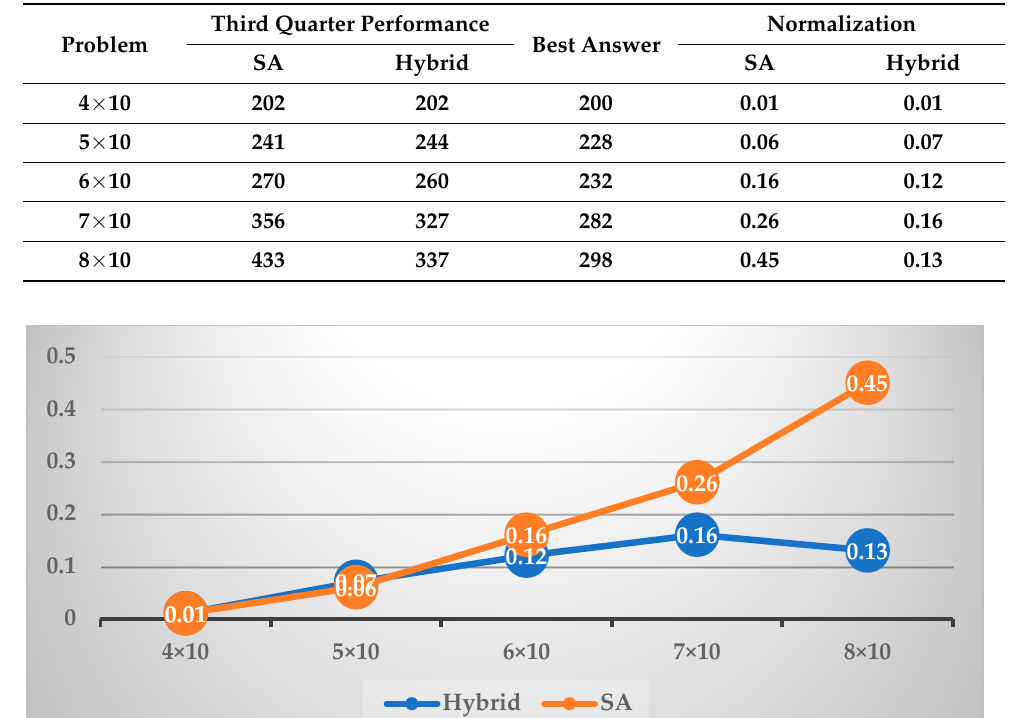
Table 7. Results of executing the SA and hybrid SA algorithms in the third quarter (10 ORs).